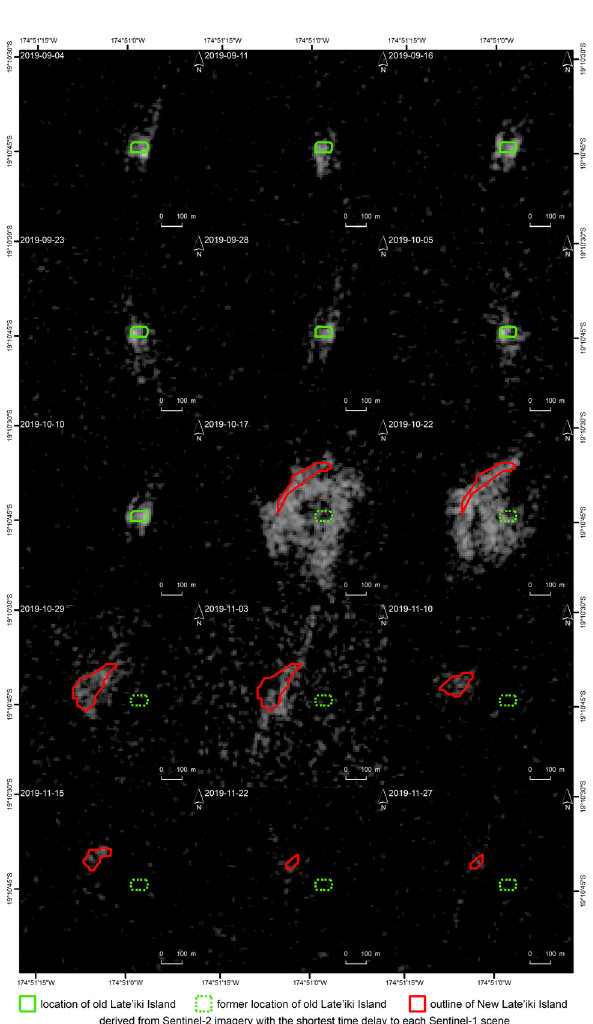
Figure 6. Late’iki Volcano as observed by Sentinel-1 SAR VH-polarized imagery from 4 September 2019 to 27 November 2019. Background: Sentinel-1 Copernicus data